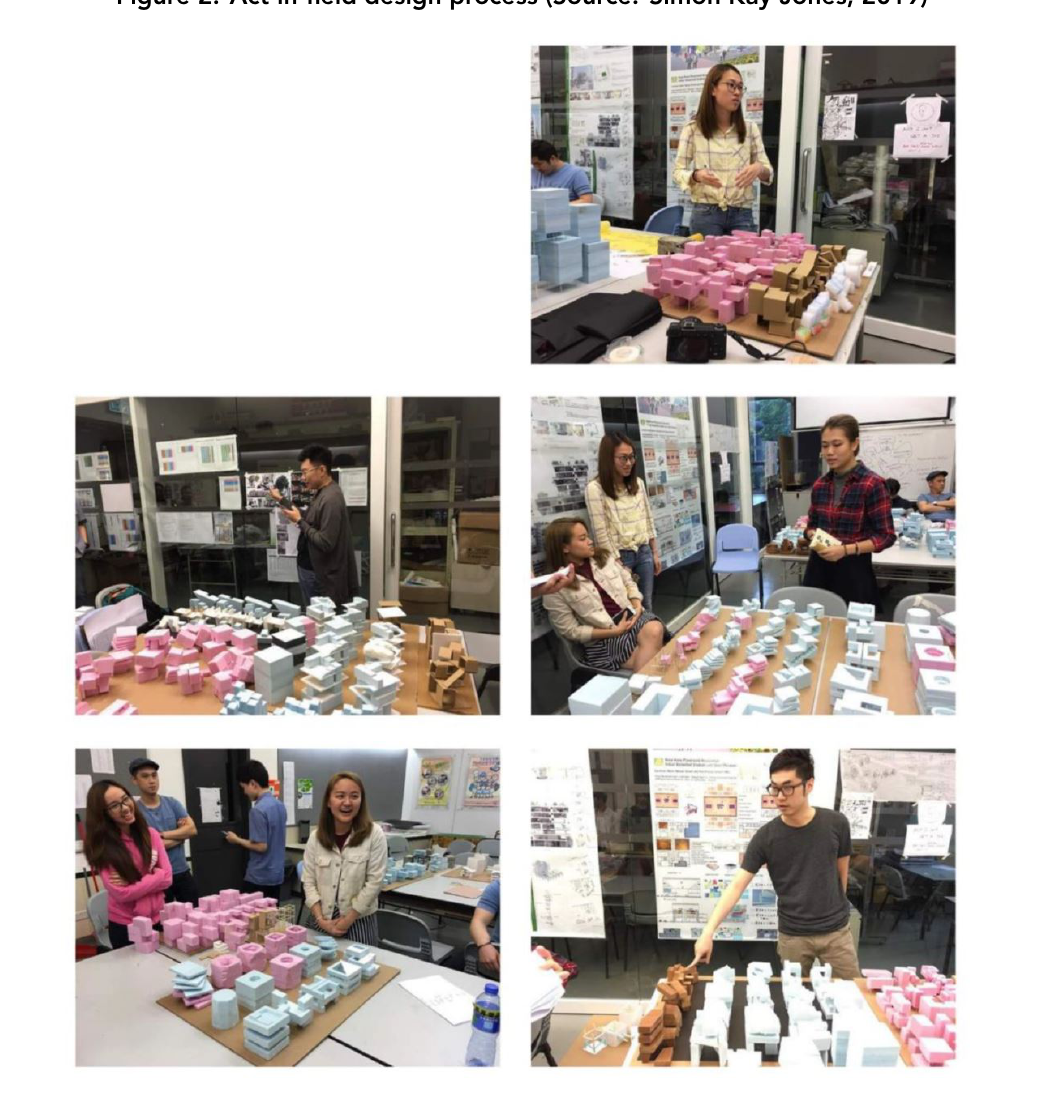
Figure 2. Act-in-field design process (Source: Simon Kay-Jones,